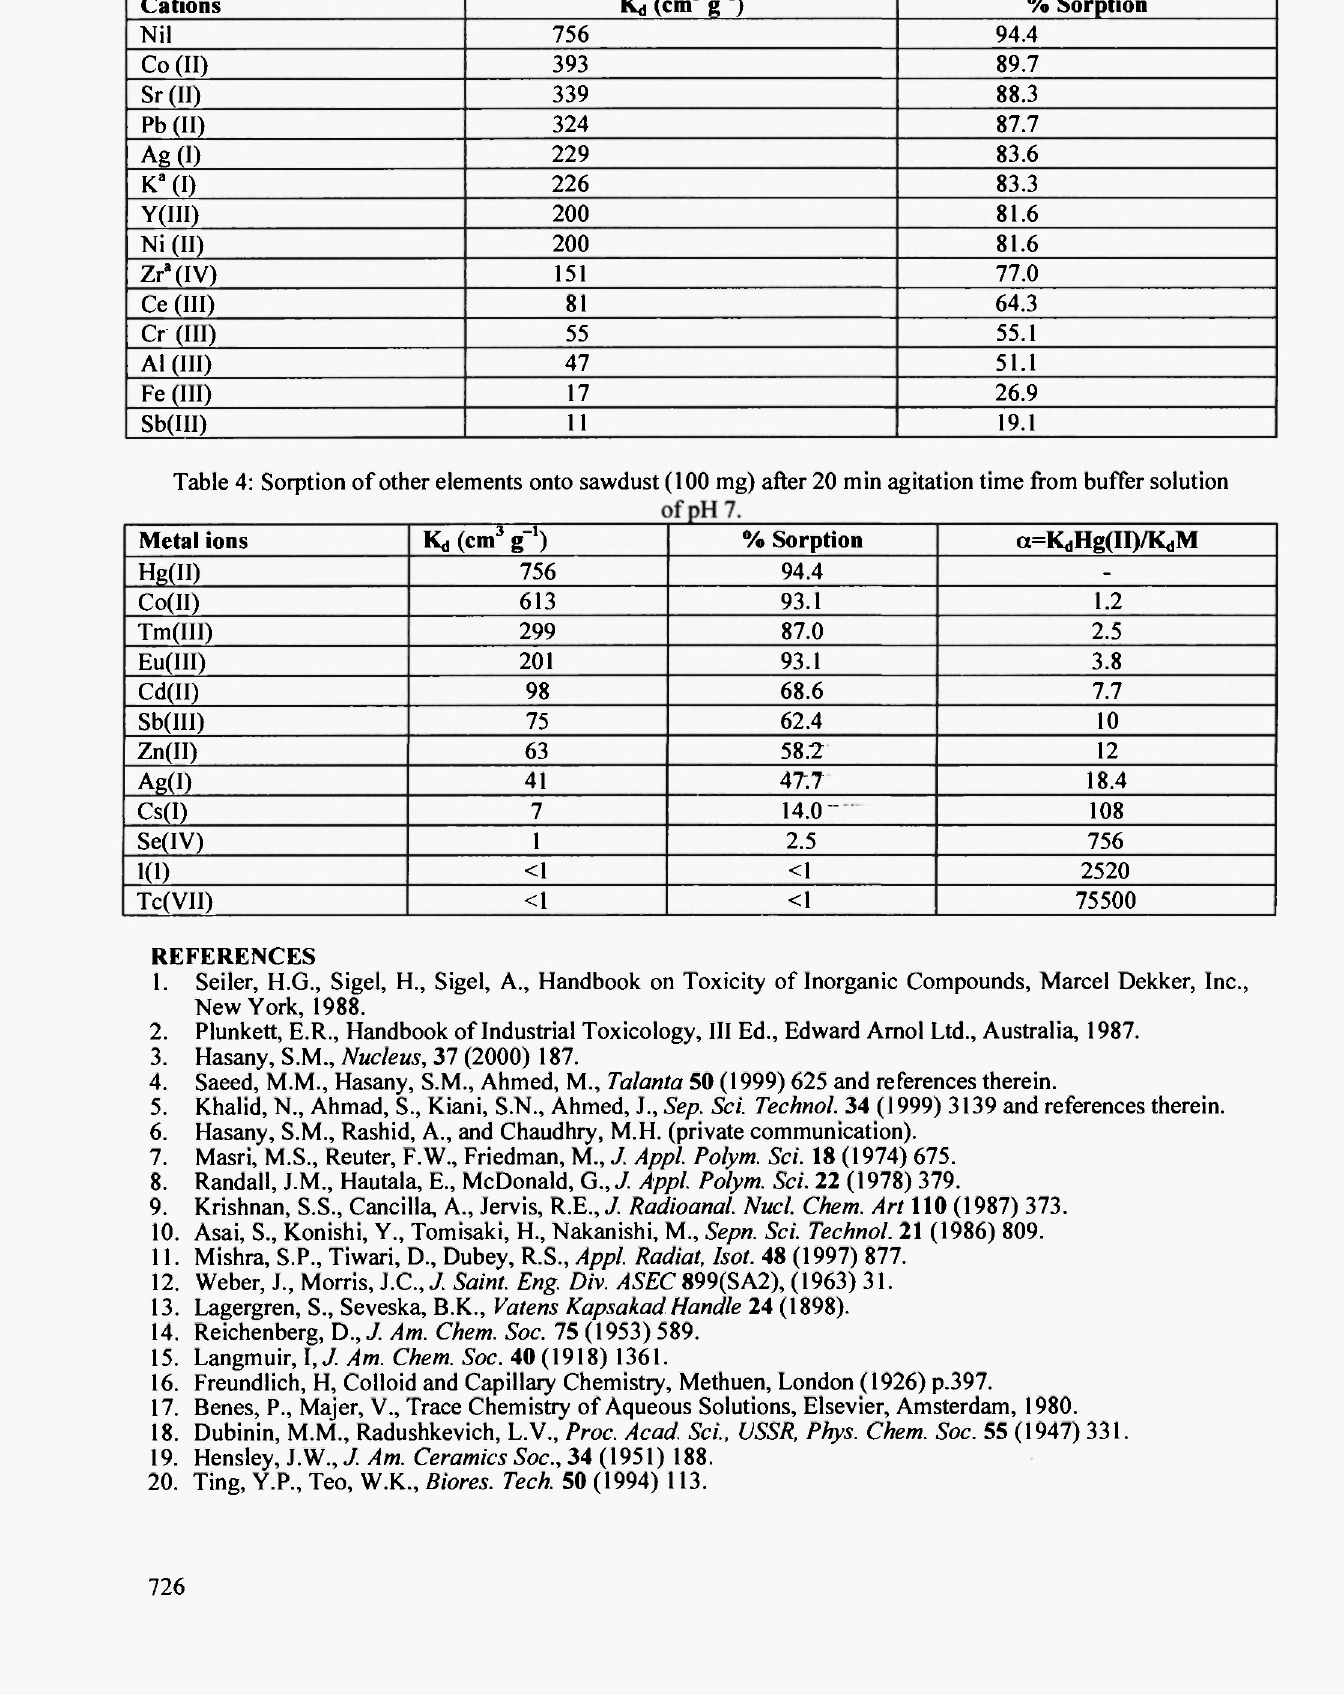
Table 3: Influence of cations on the sorption of Hg (II) ions (9.37x10" 6 M) onto sawdust (100 mg) after 20 min agitation time from buffer solution of pH 7 (a = added as chloride).